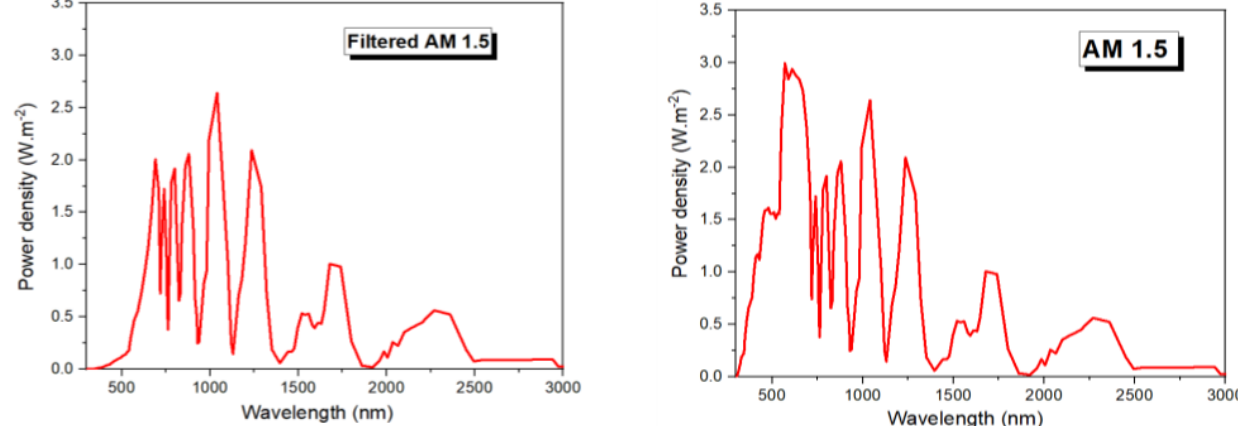
Figure 2. ( a ) AM 1.5 spectrum absorbed by the perovskite top sub-cell and ( b ) filtered AM 1.5 absorbed by the silicon bottom sub-cell obtained with Equation (1).